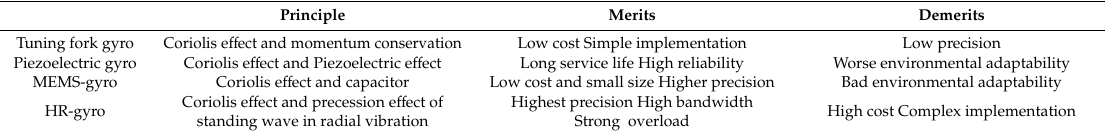
Table 1. Comparison between resonator